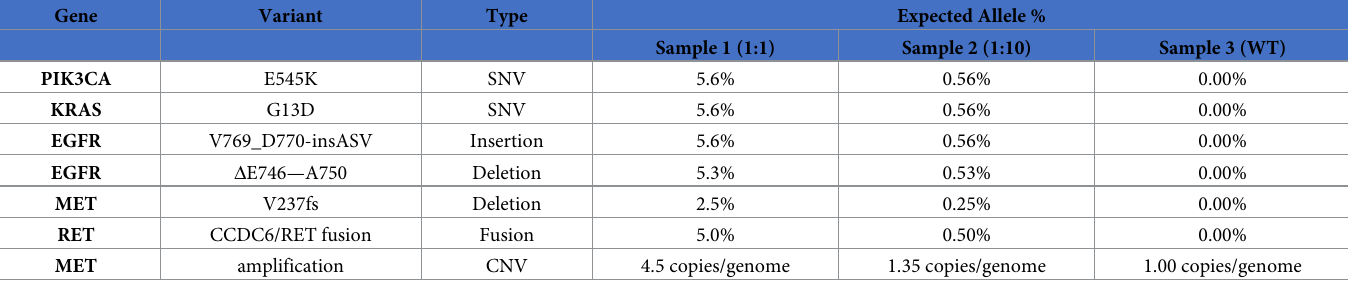
Table 2. Reference standard variants. The expected allele percentage was measured and specified by the manufacturer using digital PCR or next generation sequencing. Expected allele percentages are given for stock samples (Sample 1), samples diluted to 1/10 of the stock concentration (Sample 2), and wild-type samples (Sample